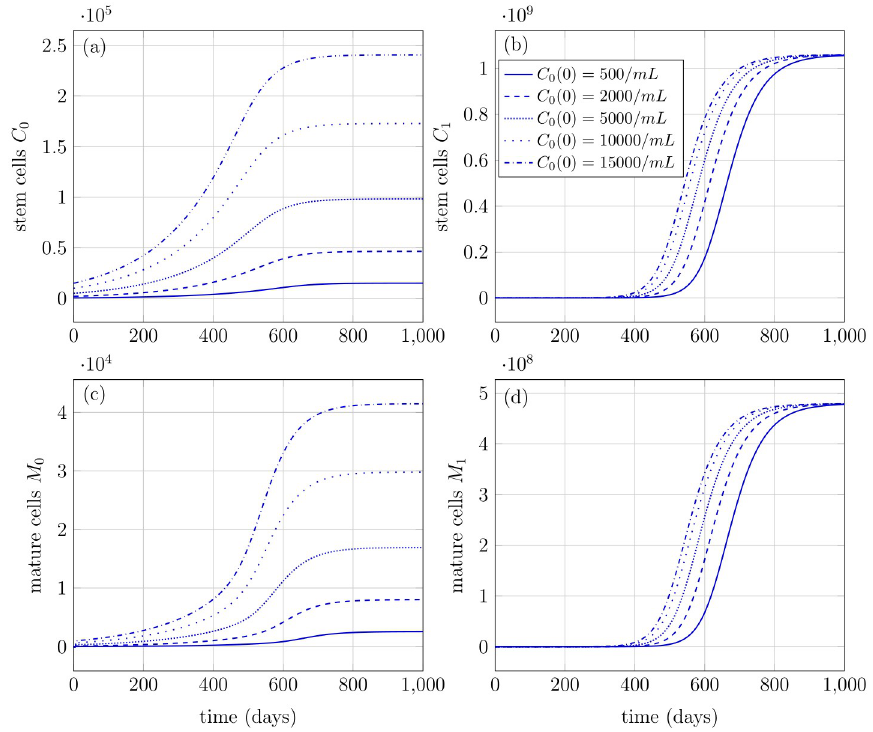
Fig 7. Number of healthy and mutated stem and mature cells with different initial conditions of healthy stem cells. The rest of the states have initial conditions equal to zero. (a) Healthy stem cells achieve a respective steady state for a corresponding initial value. (b) Mutated stem cells with initial condition equal to zero, attain a same steady-state at all initial values of C 0 ( t ). (c) Healthy mature cells with initial condition equal to zero, depict the same behavior as healthy stem cells. (d) Mutated mature cells depict a similar behavior as mutated stem cells with initial condition equal to zero.